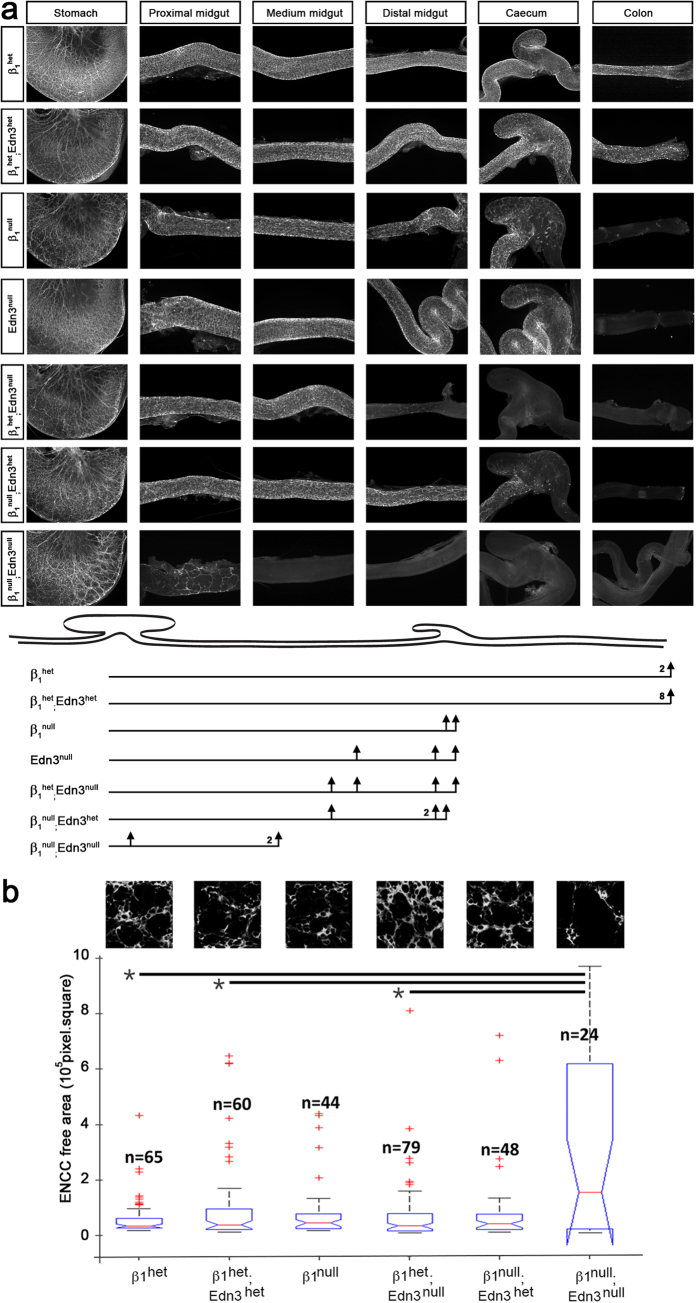
The genetic interaction between Edn3 and Itgb1 controls ENS development.(a) Images of whole-mount TUJ1 immunostaining of E14.5 guts from β1het, β1het;Edn3het, β1null, Edn3null, β1het;Edn3null β1null;Edn3het and β1null;Edn3null embryos. A schematic representation of the gut with the lines and perpendicular arrows indicating the extent of colonization for each class of genotyped embryos is shown at the bottom. The number of embryos analysed are indicated to the left of each arrow. (b) The ENS network organisation of each class of genotyped embryos. Top panels show confocal compilations of TUJ1 staining taken at the proximal portion of the small intestine. The graph shows the quantification of TUJ1-free areas relative to the mean area summarized as box plots. The top and bottom of each box indicates the 25th and 75th percentiles, respectively. The red line in the middle of the box indicates the median. n indicate the number of TUJ1-free areas analysed.